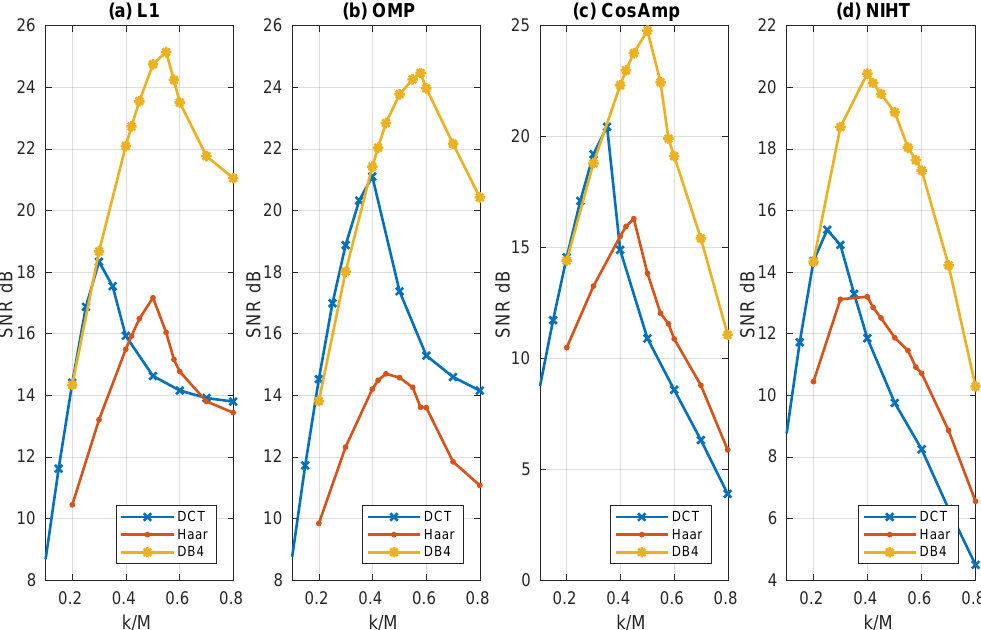
Figure 4. Case Study A—SNR as a function of sparsity S M = k / M with a compression factor CF = 0.5, for the four algorithms, ( a ) L1, ( b ) OMP, ( c ) CoSaMP, ( d ) NIHT, using the same bases of Figure 1.